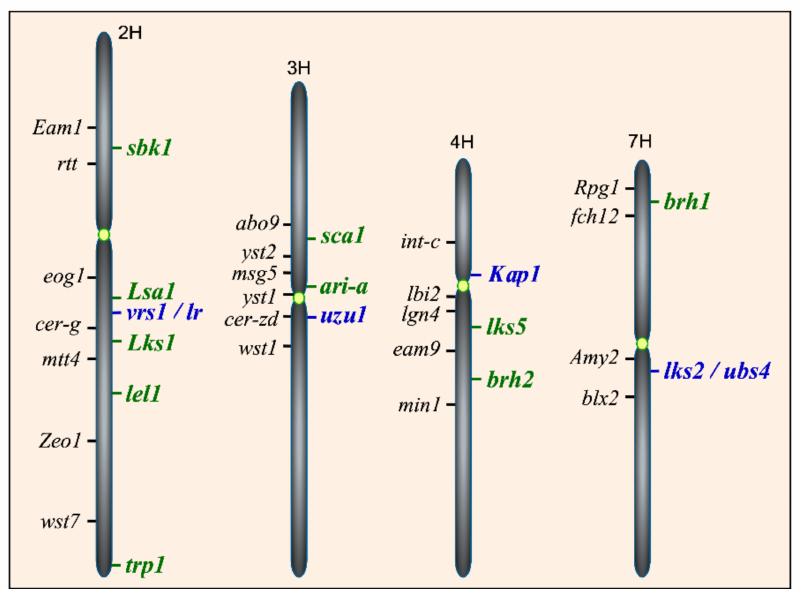
Figure 3. Cloned and mapped awn loci on barley chromosomes. Chromosomes 1H, 5H, and 6H do not contain known loci for awns and are not shown. Illustrated on the right sides of chromosomes are four cloned genes (shown in blue, vrs1/lr , uzu1 , Kap1 and lks2/ubs4 ) that regulate awn development and 10 mapped awnness loci (shown in green) that are described in this review. Morphological markers near the awnness loci are indicated in black and listed on the left side of